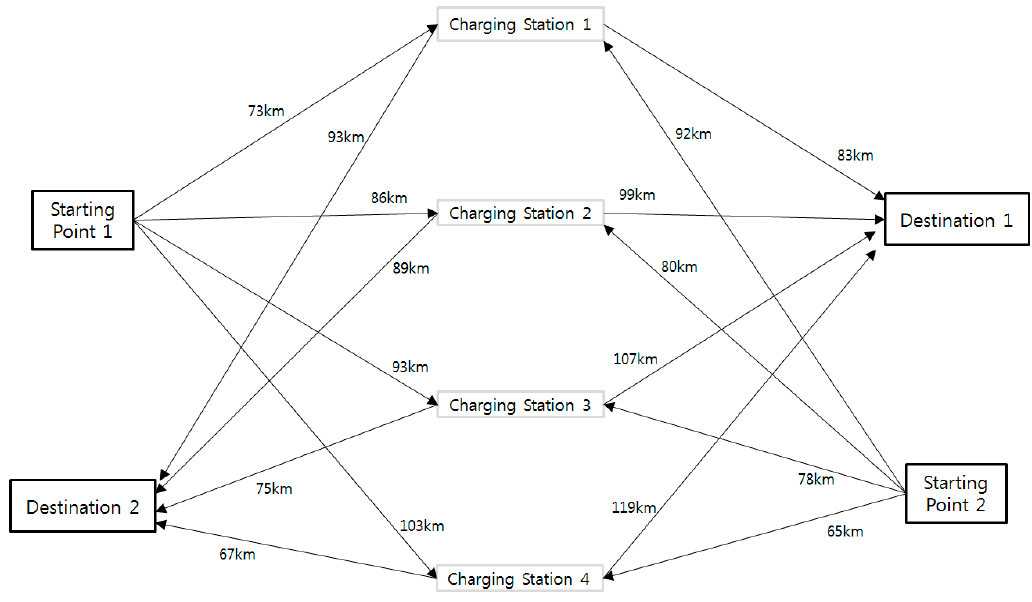
Figure 14. Route from starting point to